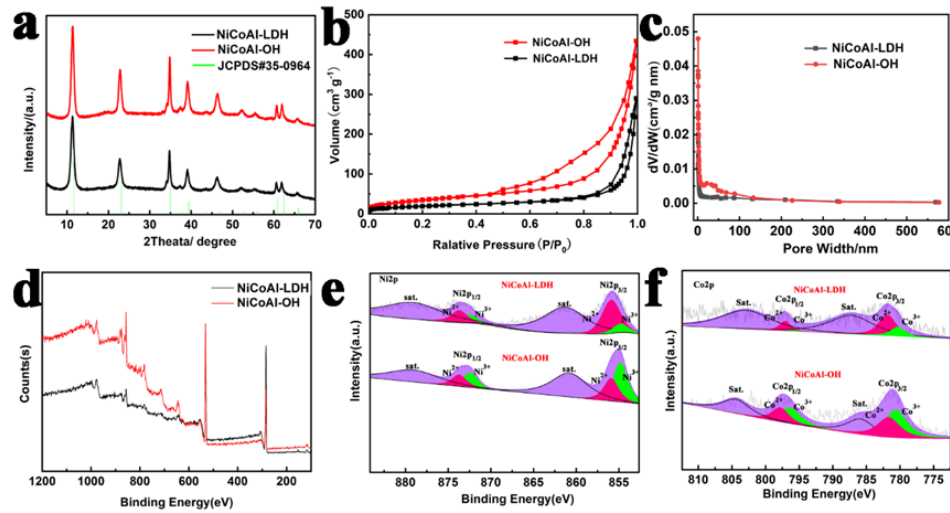
Figure 2. ( a ) Typical XRD patterns of the as-prepared NiCoAl-LDH and NiCoAl-OH. ( b ) N 2 sorption isotherms of NiCoAl-LDH and NiCoAl-OH. ( c ) Pore size distribution of NiCoAl-LDH and NiCoAl- OH. ( d ) XPS spectra of NiCoAl-LDH and NiCoAl-OH. High-resolution XPS measurements of ( e ) Ni 2p 3/2 and Ni 2p 1/2 , ( f ) Co 2p 3/2 and Co 2p 1/2